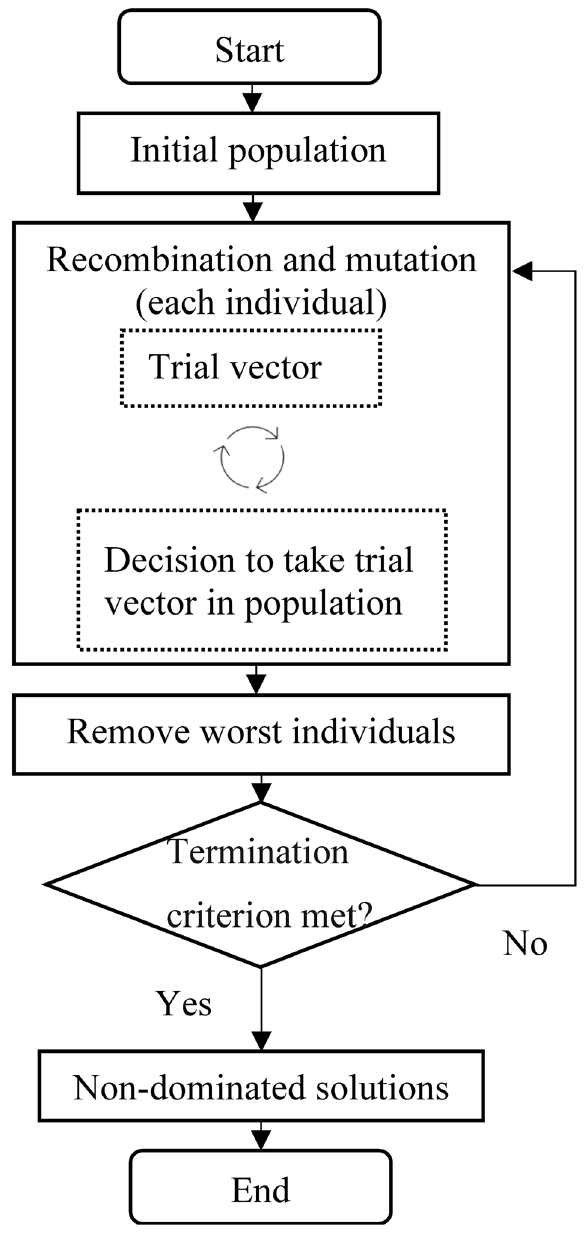
Figure 17. Optimization procedure for generalized differential evolution